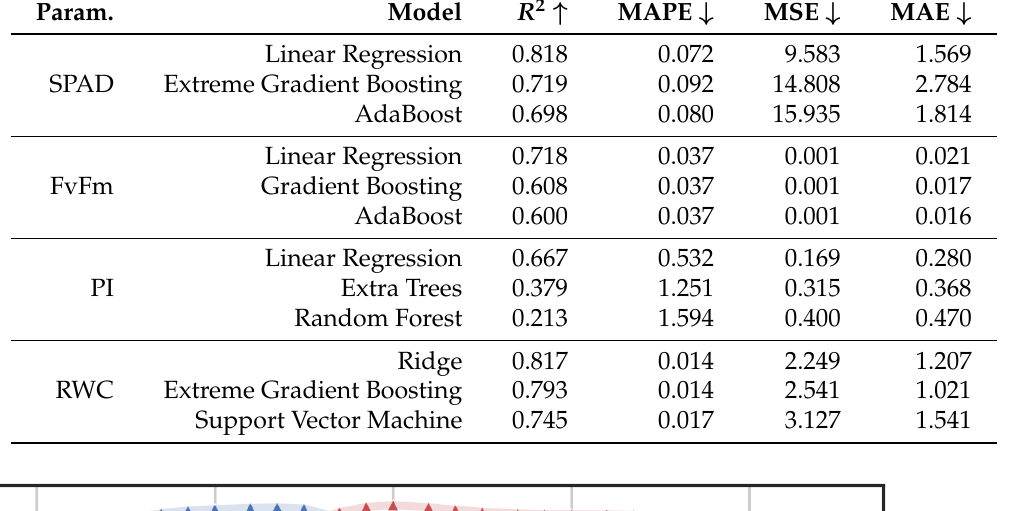
Table 5. Three best machine learning models (according to R 2 ) with default parameterization for each ground-truth parameter. We indicate if the metric should be minimized ( ↓ ) or maximized ( ↑ ). Param.